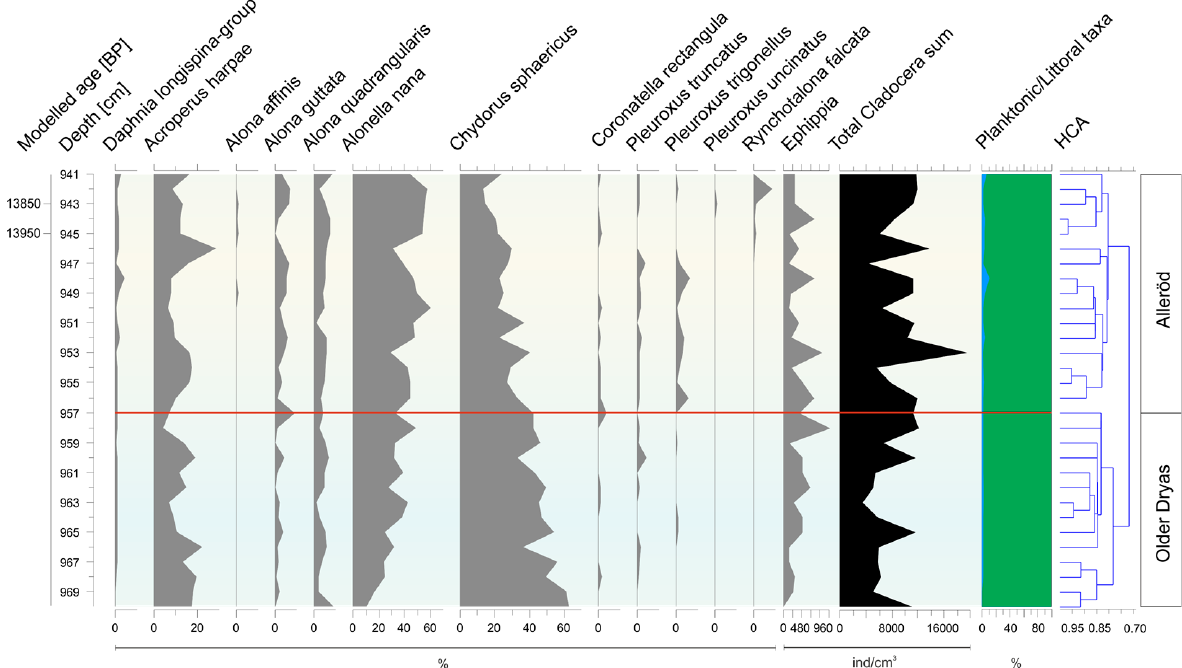
Figure 3. Diagram of percentage composition and the total sum of Cladocera specimens in sediments of the core Z-3 determined for Older Dryas/Alleröd transition. HCA: Hierarchical Cluster Analysis.